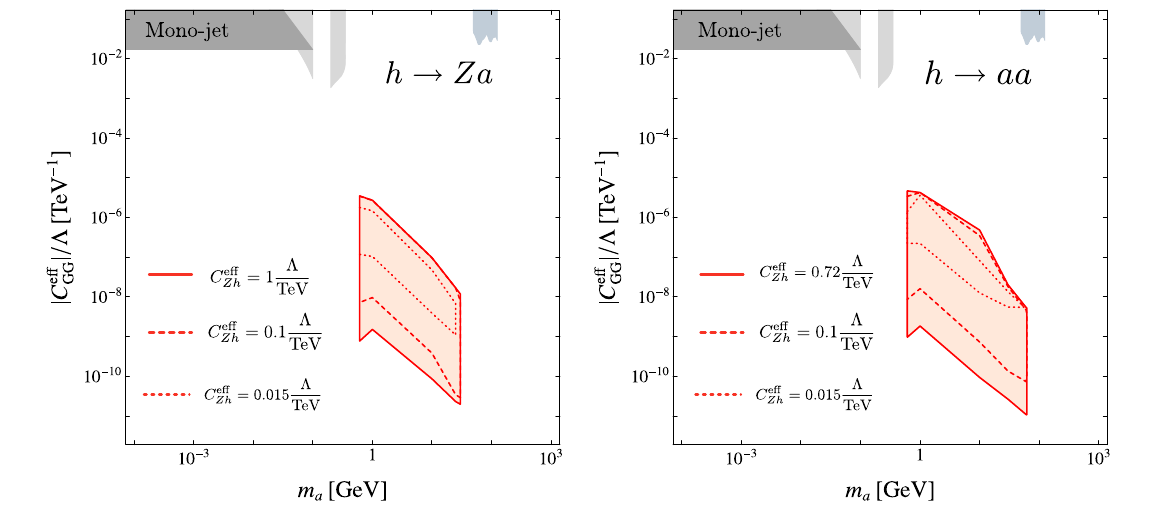
Fig. 21 Projected exclusion contours for searches for pp → h → Za (left) and pp → h → aa (right) with the subsequent ALP decay a → gg and Br ( a → gg ) = 1 with the MATHUSLA detector. The